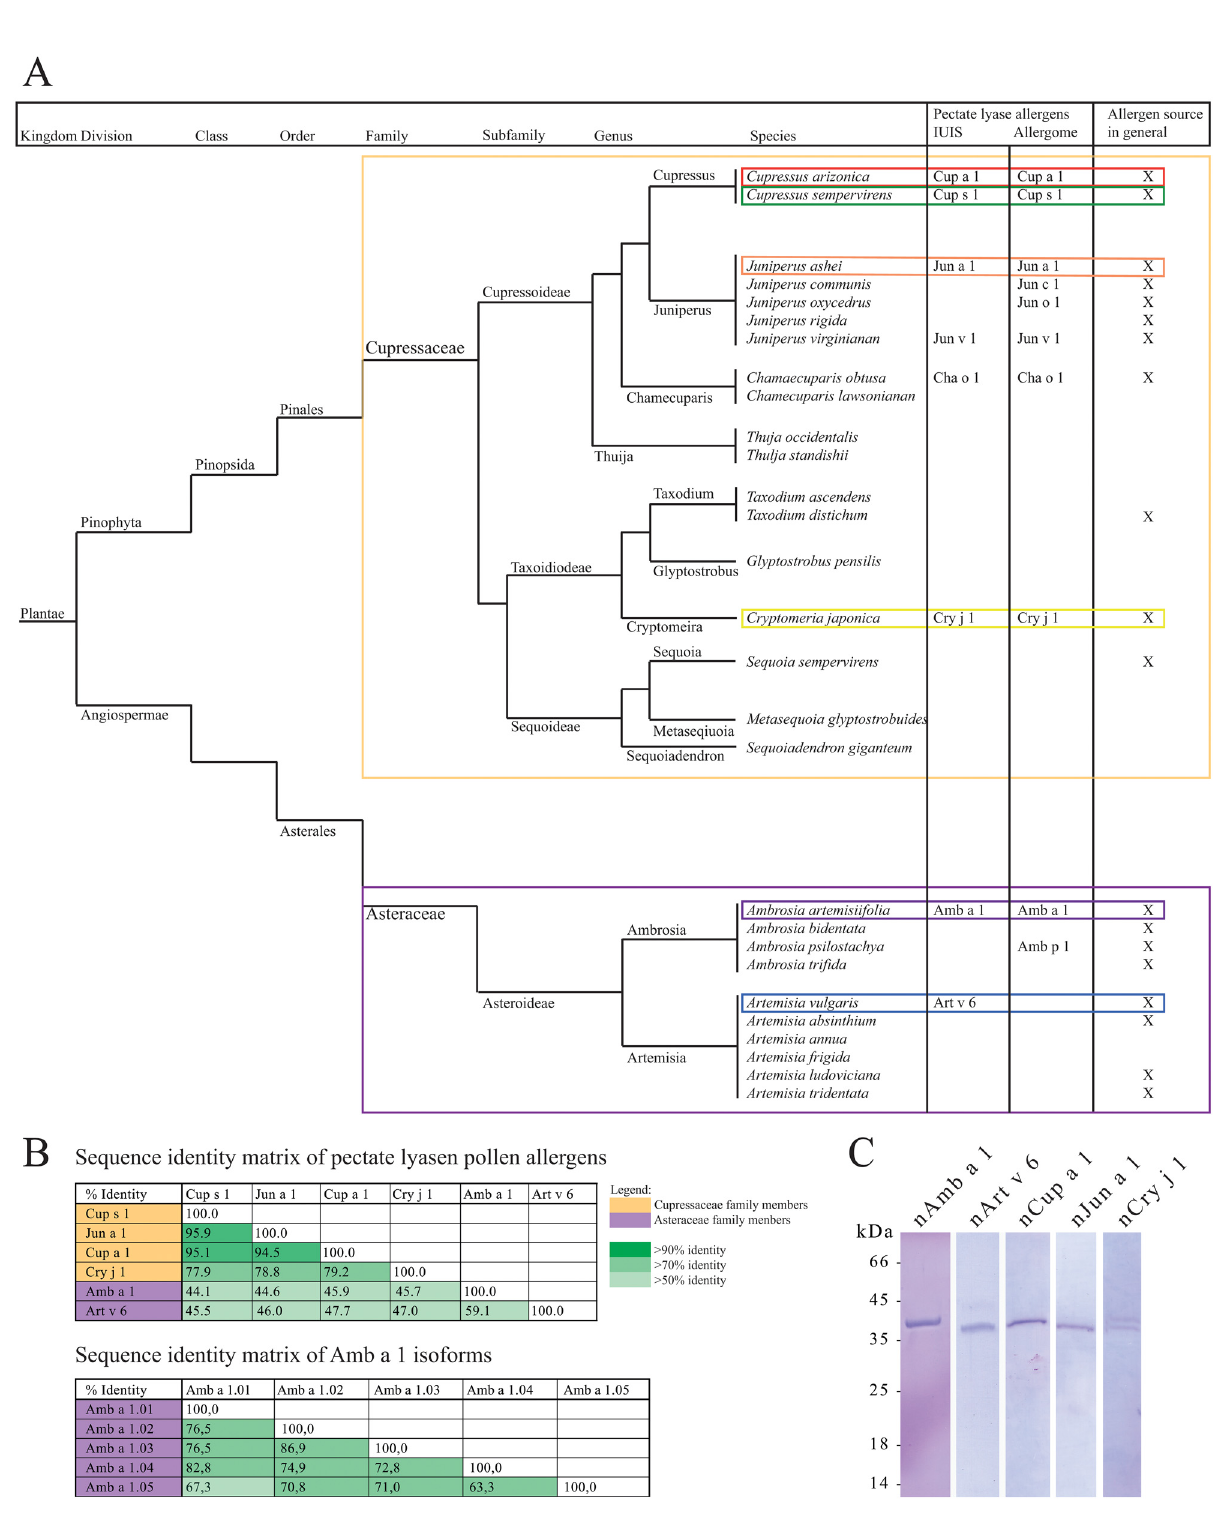
Fig 2. Taxonomy of Cupressaceae and Asteraceae and SDS-PAGE of purified allergenic proteins. (A) Phylogenetic tree of Cupressaceae and Asteraceae species. (B) Identity matrix of pectate lyase pollen allergens and, in case of Amb a 1, allergen isoforms. (C) SDS-PAGE of allergenic pectate lyases purified from pollen extracts by anion-exchange chromatography and/or size exclusion chromatography. The gel was stained with Coomassie Brilliant Blue R-250. Natural Cry j 1 migrates as visible double band.